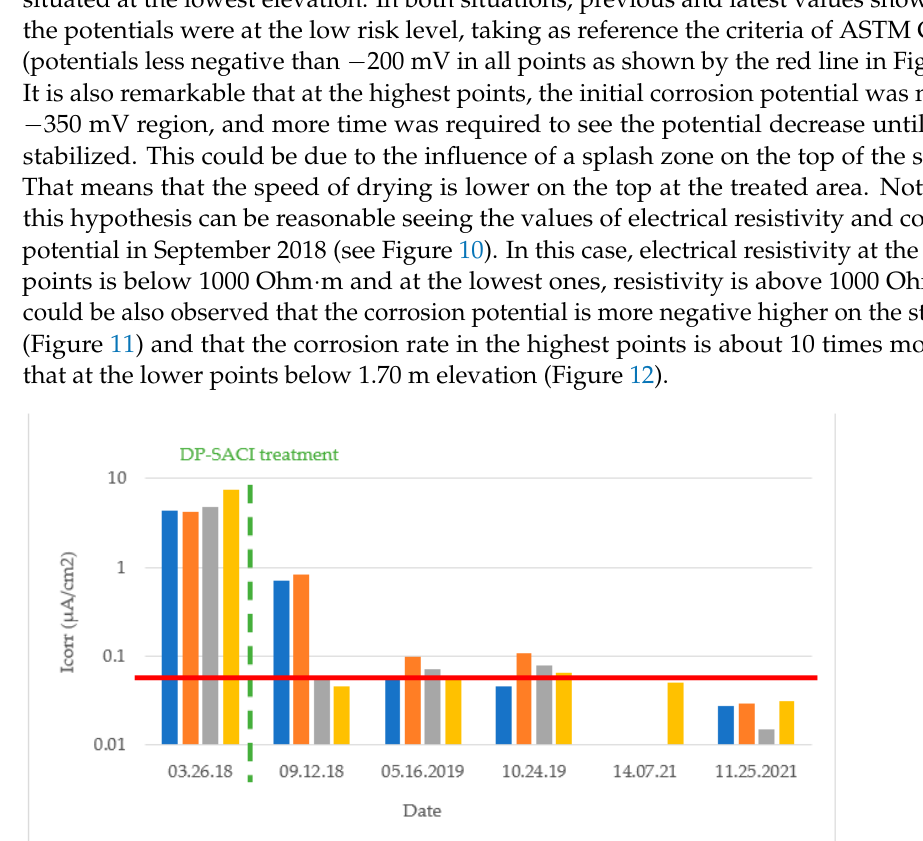
Figure 12. Icorr evolution over the treated area at reference test points after DP-SACI treatment.